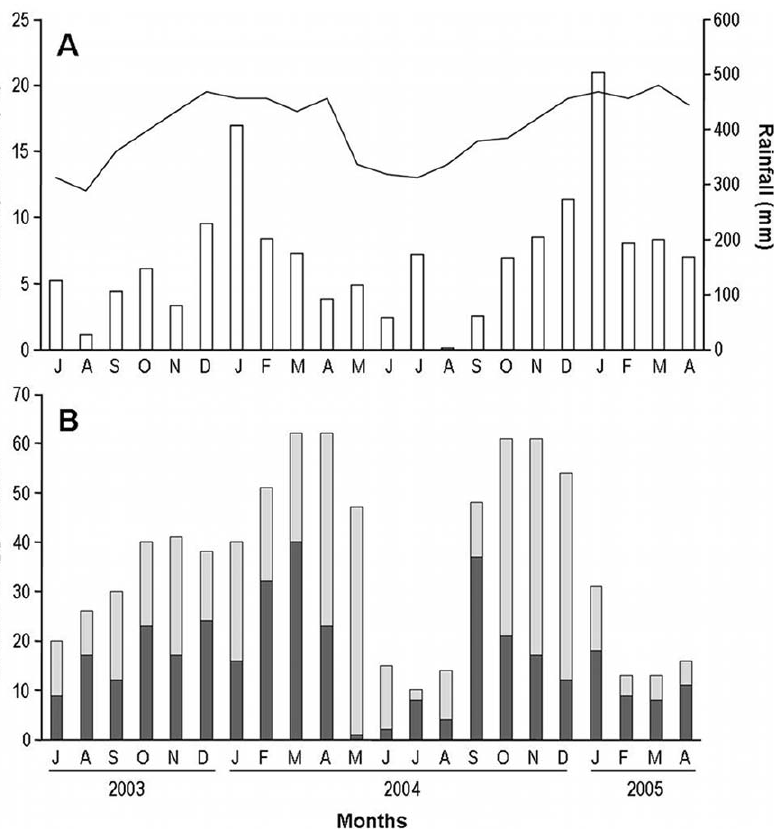
Figure 2. Climatic conditions and number of Iporangaia egg-batches observed in the sampled area. (A) The solid line represents temperature; black bars represent the rainfall during the dry-cold season; white bars represent the rainfall during the wet-warm season. (B) Dark-gray bars represent the number of new egg-batches found in each month (i.e., those that were not present in the transect in the previous months); light- gray bars represent old egg-batches (i.e., that were already present in the transect in the previous months).